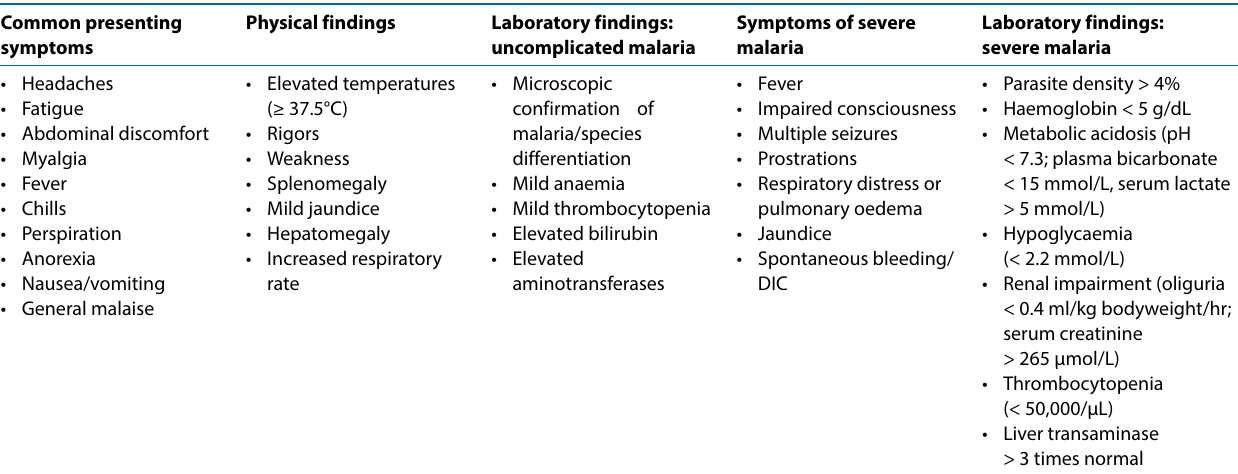
Table l: Clinical and laboratory indicators of uncomplicated and severe malaria 4,7-9